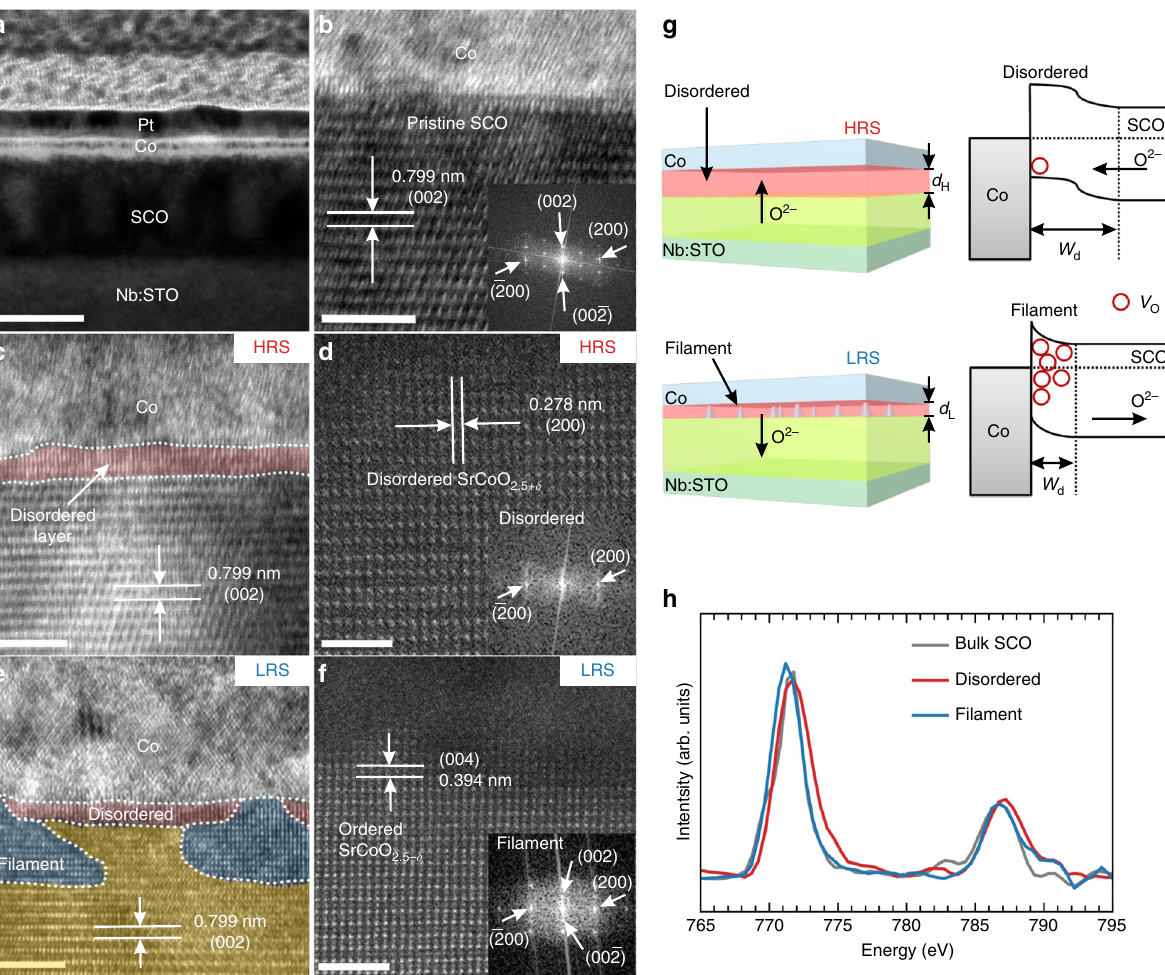
Fig. 3 Oxygen ion evolution at Co/SrCoO 2.5 interfaces. a Cross-section low-resolution TEM image of the device structure, in which the scale bar is 50 nm. HRTEM image of Co/SrCoO 2.5 heterointerface at ( b ) the pristine state and ( c ) the high-resistance state. The disordered SrCoO 2.5+ δ region could be clearly identi fi ed as compared with the pristine state, as shown in the magni fi ed image ( d ). e HRTEM image of the Co/SrCoO 2.5 interface in the low-resistance state with the observation of conducting fi laments (highlighted by the blue areas). The red and yellow areas denote the remaining disordered and pristine regions, respectively. f Detailed crystalline structure at the conducting fi lament, which are composed of ordered SrCoO 2.5 − δ with pronounced oxygen vacancies ( V O ). The insets of ( b ), ( d ), and ( f ) show the diffraction patterns obtained by local FFT. g Schematic diagram of the oxygen ion evolution with the corresponding band alignments at the heterointerface. h Comparison of Co L -edge EELS spectra of the disordered area and the conducting fi lament at the interface, as well as the bulk region of the SrCoO 2.5 layer. The L 3 peak values of the fi laments, pristine and disordered regions are 771.2, 771.5, and 771.7 eV, respectively. The scale bar indicates 5 nm in ( b ), ( c ) and ( e) and 2 nm in ( d ) and ( f